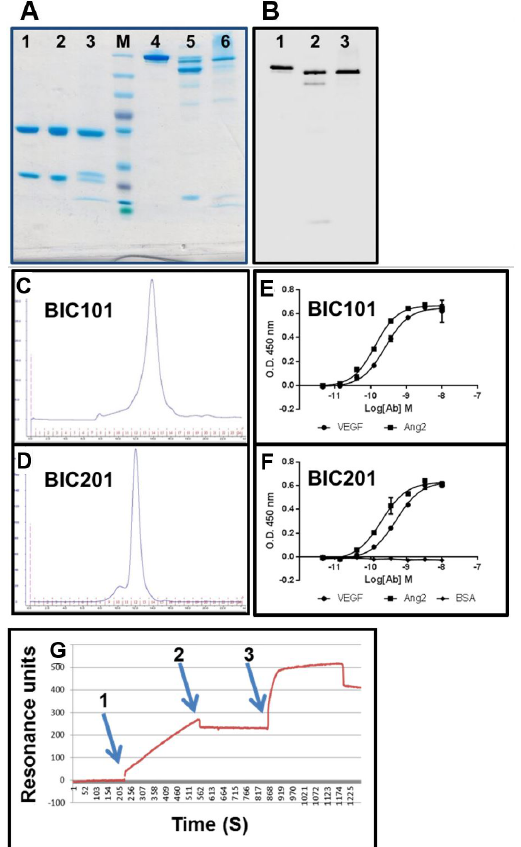
Figure 12. Production and evaluation of an anti VEGF—anti Ang2 bispecific IgG produced by refolding and in CHO cells. ( A ) Samples of purified BIC101 (made by refolding) and BIC201 (made in CHO cells) were analyzed by SDS/PAGE. Lanes 1 and 4, the commercial mAb bevacizumab (Avastin), lanes 2 and 5, BIC201, lanes 3 and 6, BIC101. 3–5 µ g were loaded per lane of a 10% acrylamide gel, samples in lanes 1–3 were separated under reducing conditions while those in lane 4–6 were not reduced; ( B ) Immunoblot